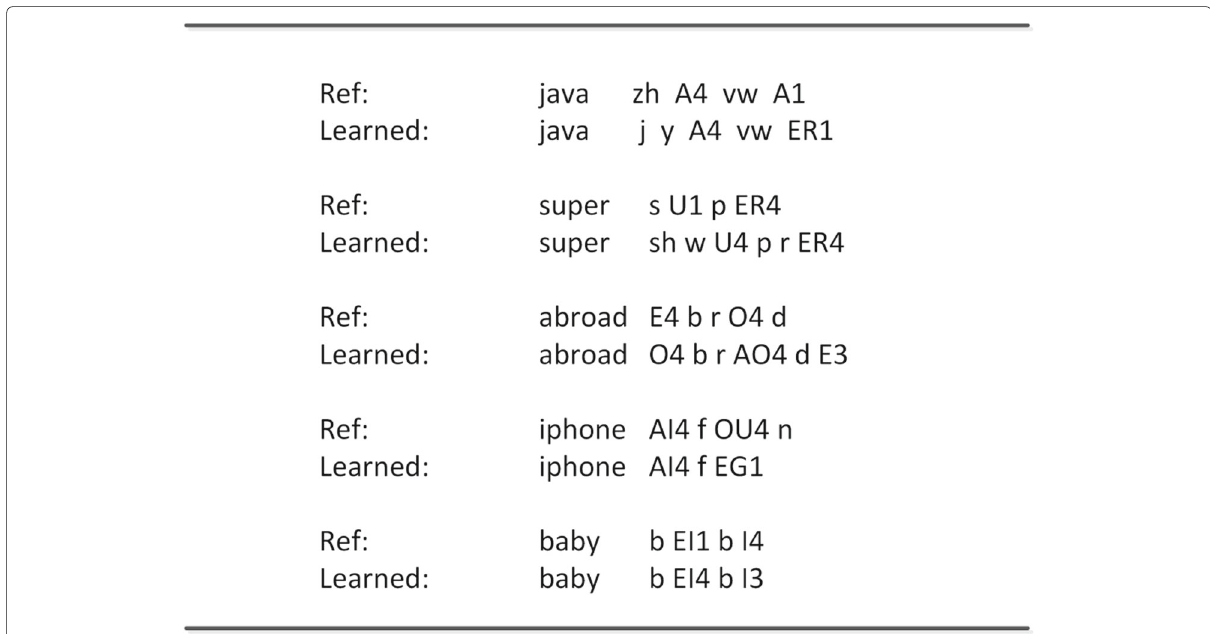
Fig. 5 Samples of learned pronunciations for embedding English words. “Ref” and “Learned” is the word-pronunciation pair in the source (“G2P Extended CS Lexicon”) and learned lexicon in Fig. 3